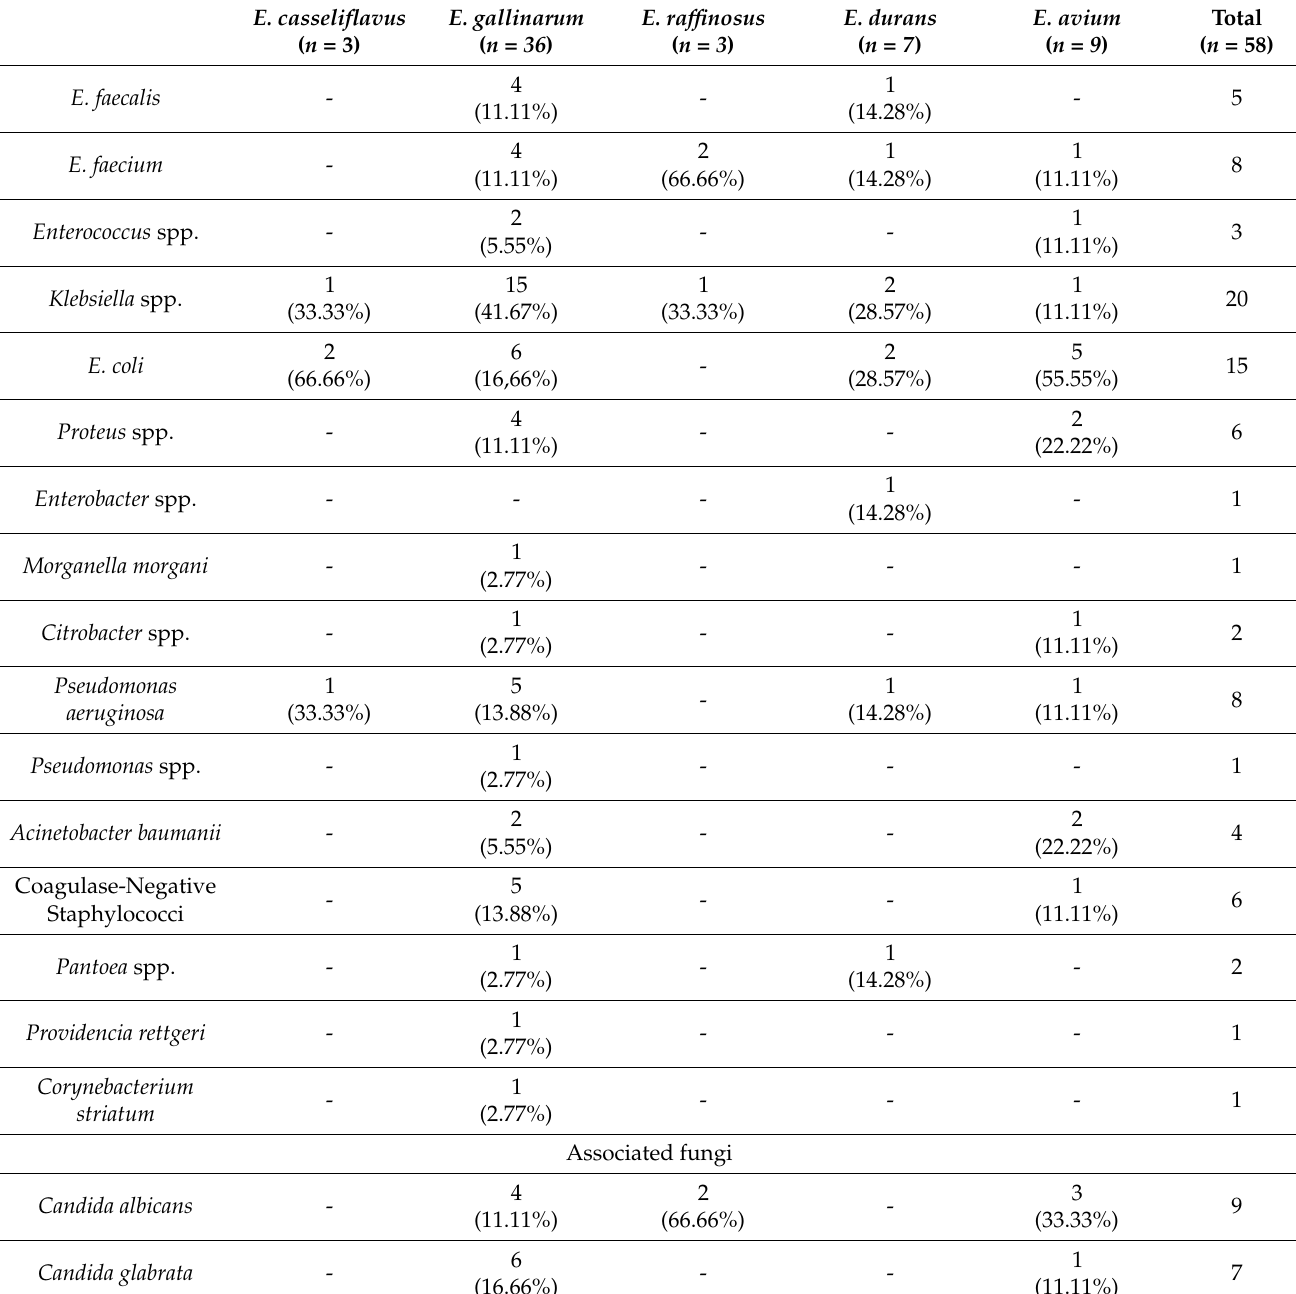
Table 3. Association of different bacteria and fungi with other Enterococci (number of associations and percentage for each species